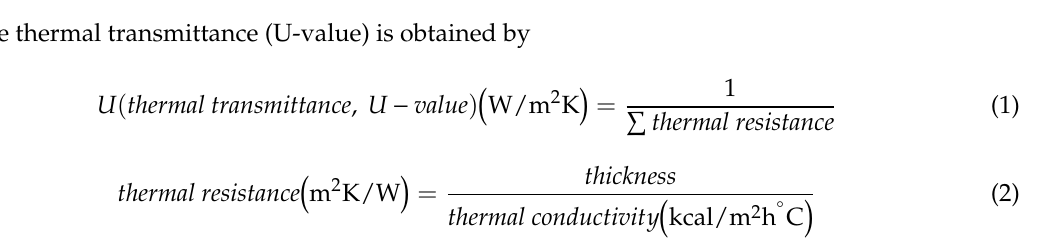
Figure 5. Eclipse Interface defining rules for building envelope property definition.